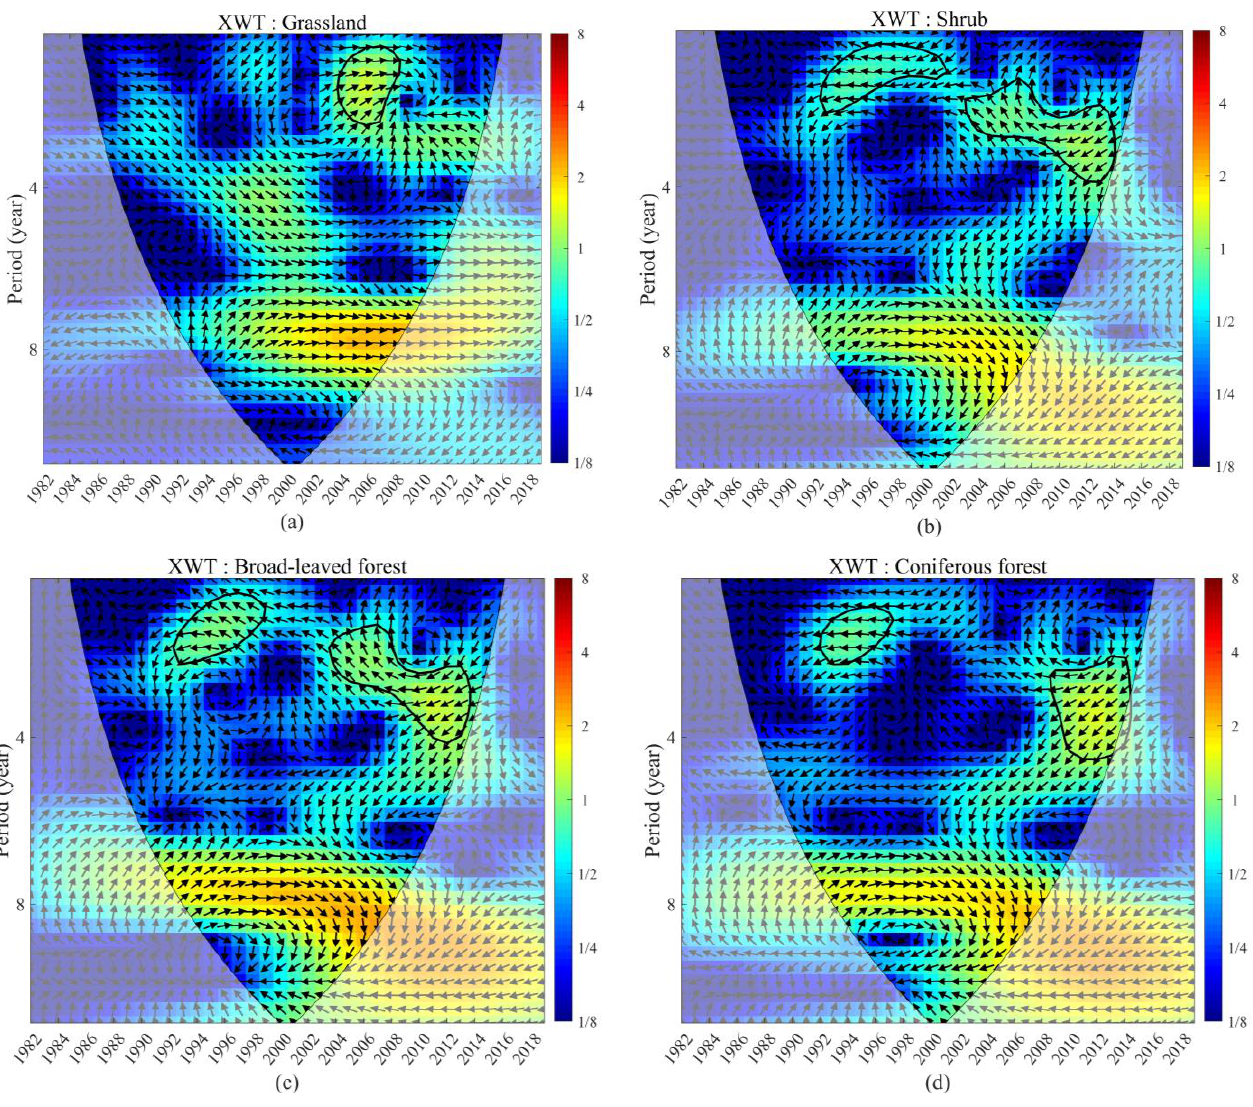
Figure 13. XWT power spectrum results of SPEI and NDVI of grasslands ( a ), shrubs ( b ), broad-leaved forests ( c ), and coniferous forests ( d ). The red and blue regions in the figures indicate the peak and valley values of energy density, respectively. The color shades represent the relative changes in energy density. The values enclosed within the thick black solid contour represent those that passed the red noise test at the 95% confidence level, while the conical area within the thin black solid line is the cone of influence (COI).